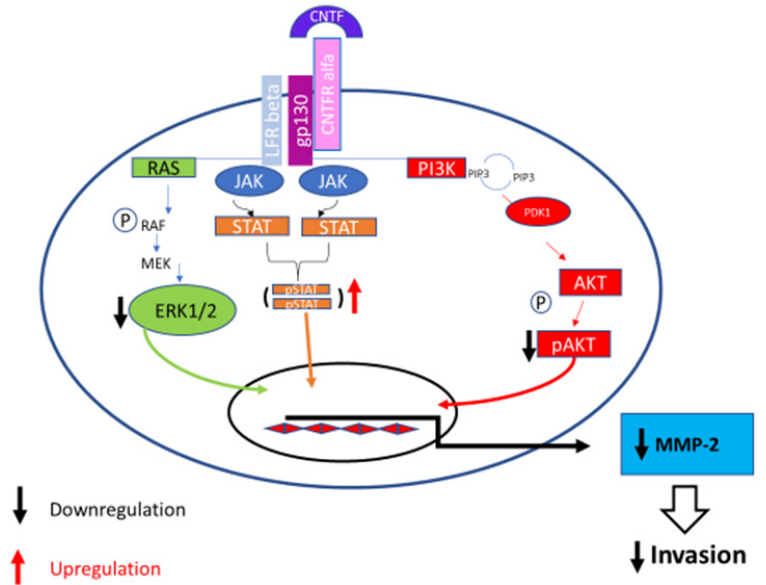
Figure 8. CNTF pathway in PCa. The binding of CNTF to the receptor actives JAK/STAT3 and downregulates MAPK/ERK, PI3K/AKT signaling pathways in CRPC cell model (22Rv1 cell line). Subsequently, MMP-2 is downregulated and cell invasion decreases.